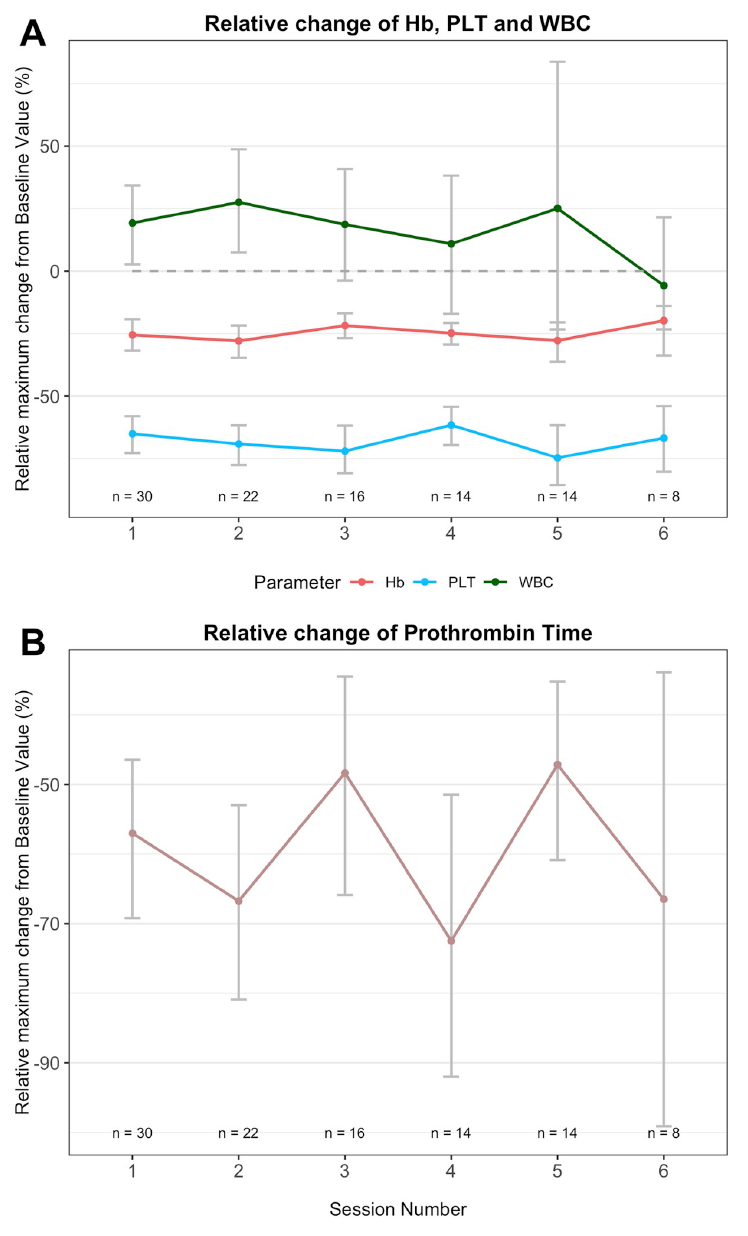
Fig 3. Habituation effect